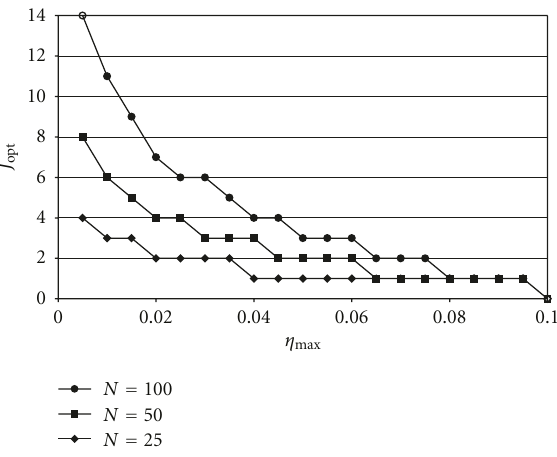
Figure 8: Fixed ELBP: optimal number of